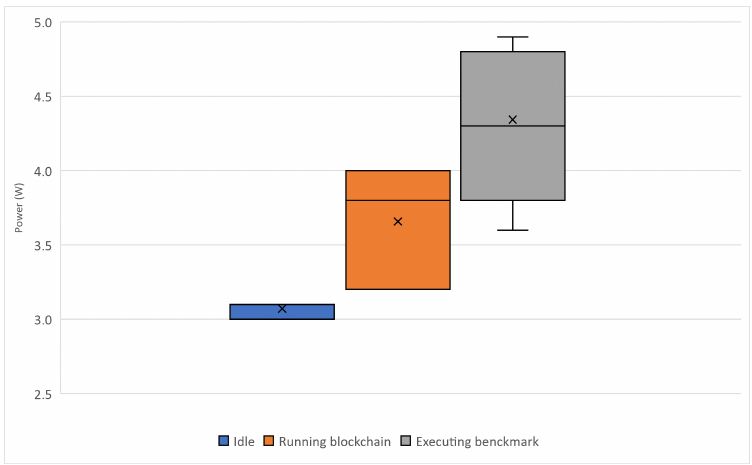
Figure 11. RPi3 power consumption in different